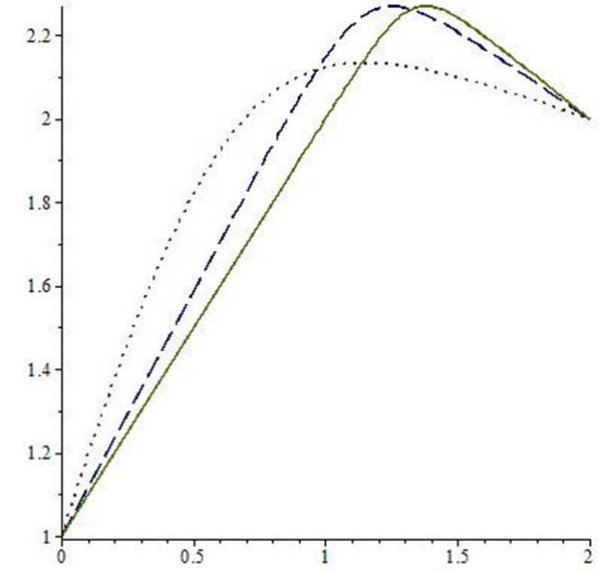
Figure 5. Function (cid:1834)(cid:4666)(cid:1875)(cid:4667) when (cid:1858) ≡ (cid:3398)1 and θ = 1 for (from left to right) ϵ = 0.5, 0.25 and